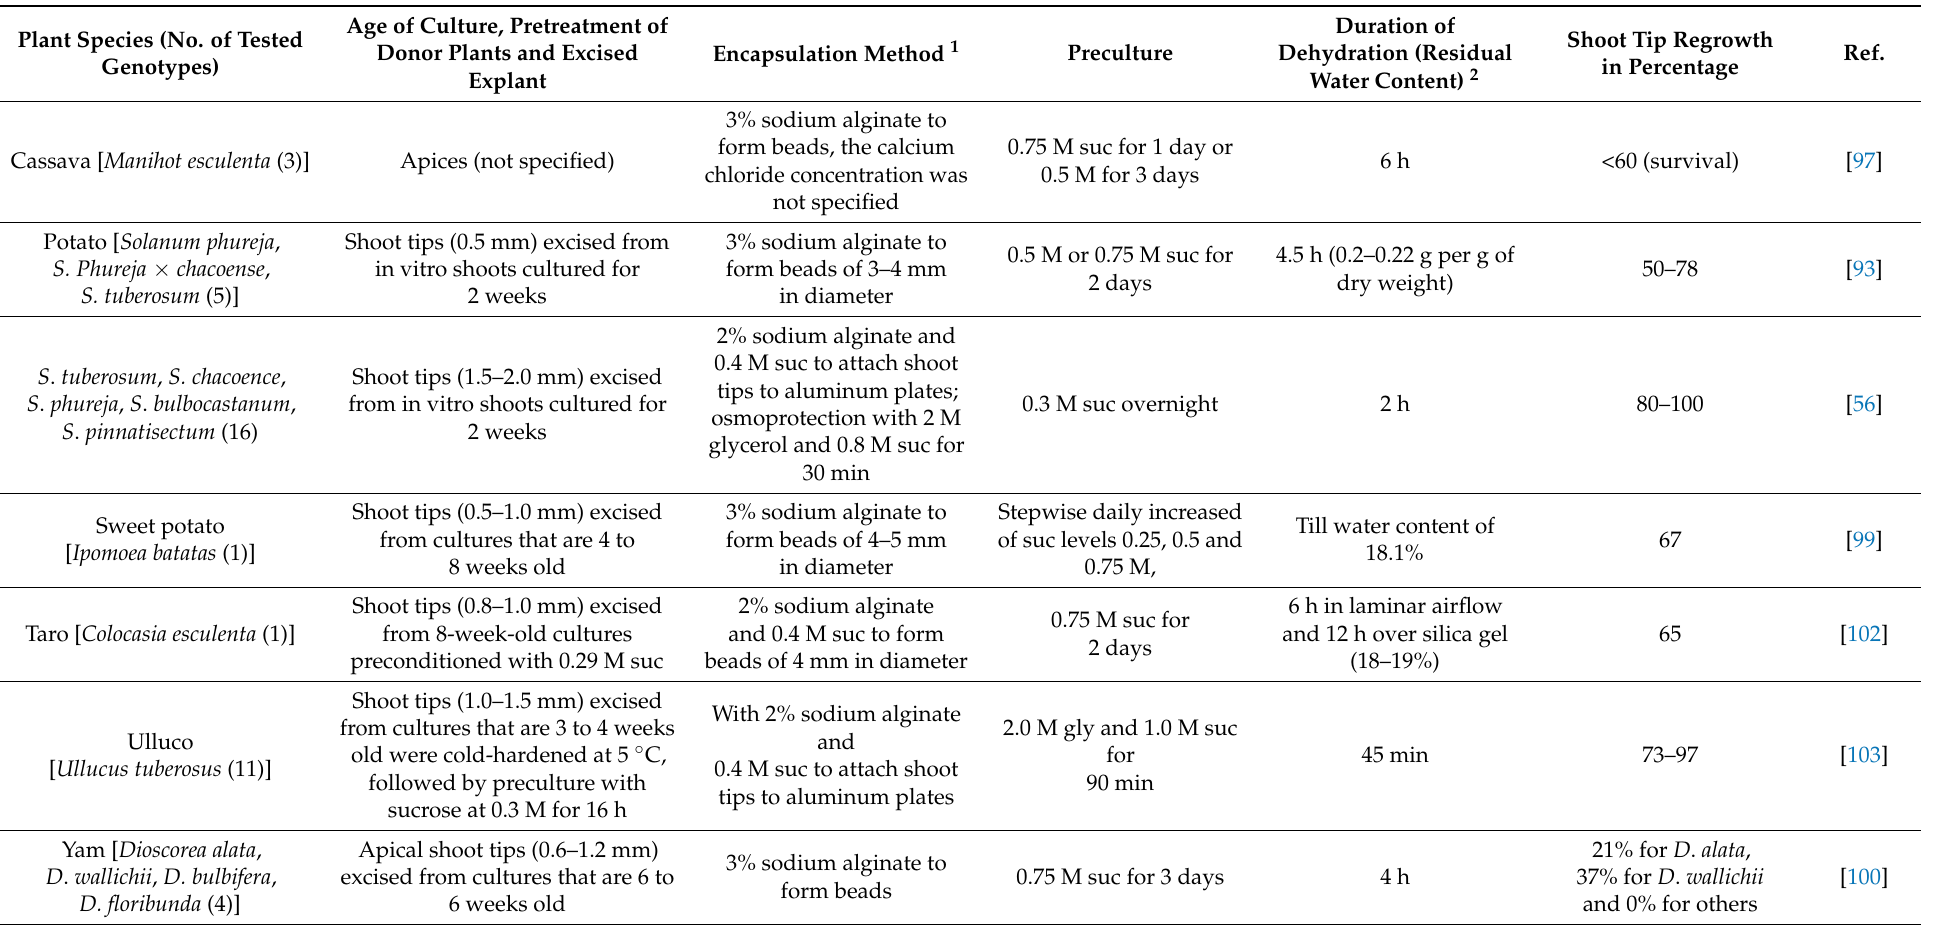
Table 1. The use of encapsulation with air drying and (ultra-) rapid freezing for cryopreservation of root and tuber crops (RTCs). Plant Species (No. of